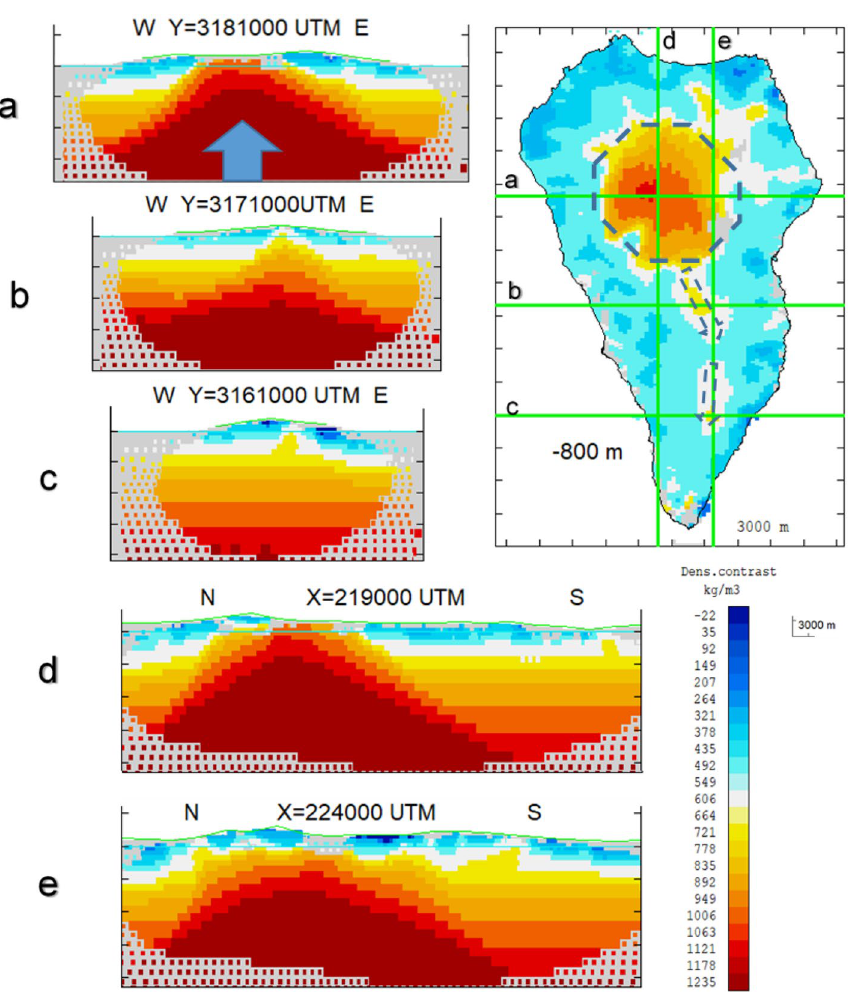
Figure 6. Vertical sections of the 3D model for anomalous density for La Palma Island. Panels ( a ), ( b ) and ( c ) show E-W sections. Panels ( d ) and ( e ) N-S sections. The cross lines are indicated in the horizontal section for a depth of 800 m bsl. The horizontal section includes some interpretative lines (dotted lines). Matlab software (www.mathw orks.com) was used to create this